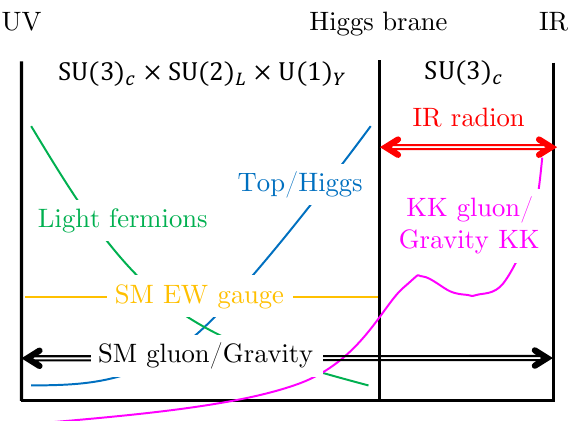
Figure 3 . The model under consideration in this study that is a variation of the extended warped model framework depicted in figure 1( b ). Only the gluon field out of the SM gauge fields is allowed to propagate in the extended